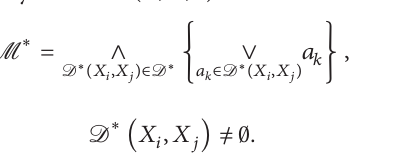
Algorithm 39. Discernibility functions are